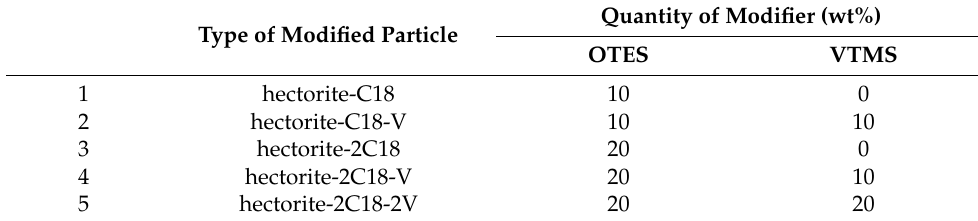
Table 1. Formulation for modifying